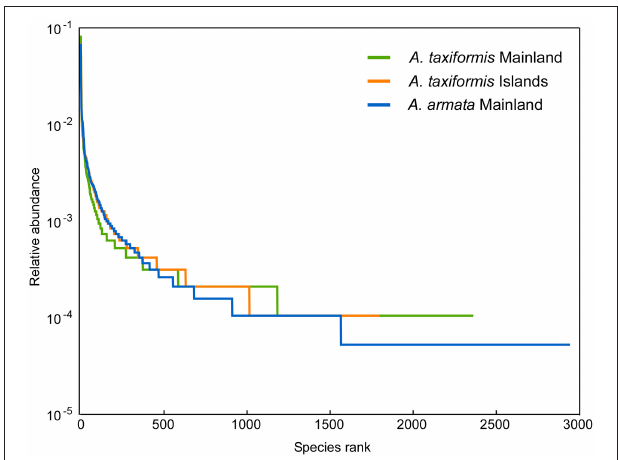
FIGURE 2 | Rank abundance curves for each Asparagopsis group plotting logarithmic relative abundances.